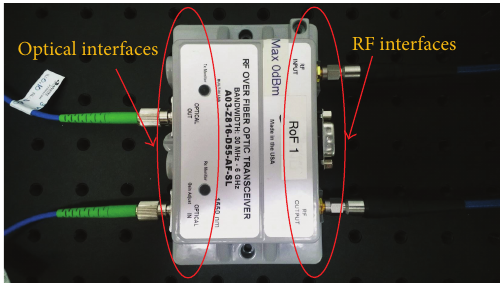
Figure 5: RoF transceiver used in the